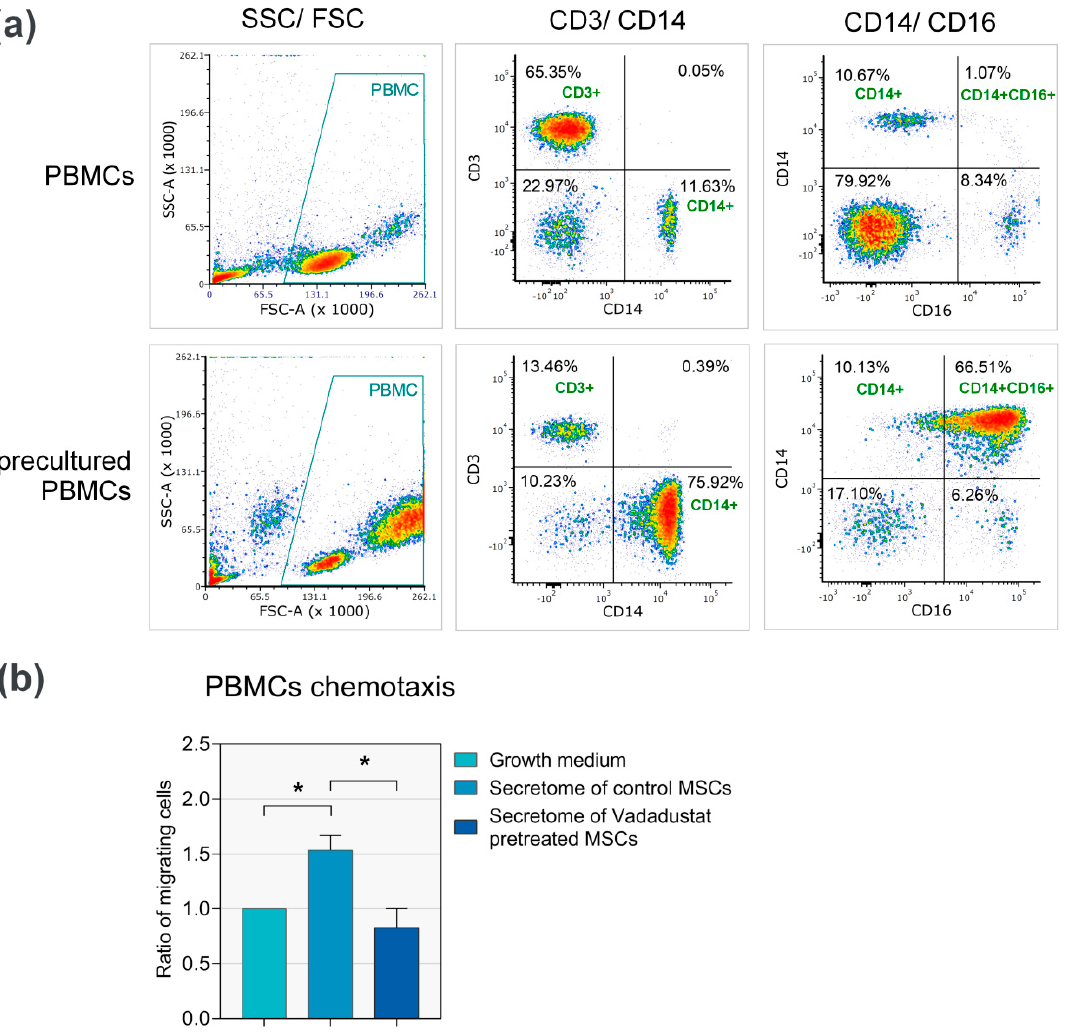
Figure 5. Assessment of the chemotactic properties of the secretome of Vadadustat preconditioned bone marrow-derived mesenchymal stromal cells (BM-MSCs). ( a ) Flow cytometric analysis of lymphocyte populations in peripheral blood mononuclear cells (PBMCs) isolated or precultured in plates based on CD3 (PerCP), CD14 (FITC) and CD16 (PE-Cy7) staining. PBMCs were gated based on FSC and SSC, percentages of monocytes (CD14 + ) and activated monocytes (CD14 + CD16 + ) in PBMCs are shown in quadrants. ( b ) The analysis of chemotactic properties of secretome from 6 BM-MSCs populations cultured for 24 h under standard conditions (control) and with Vadadustat on the migration of monocyte-enriched peripheral blood mononuclear cells (PBMCs) (precultured PBMCs). The rate of cell migration is presented as the ratio of migrating cells ± SEM (standard error of the mean), obtained by comparing the fluorescence of PBMCs migrated to the growth medium (denoted as 1) with the fluorescence of PBMCs migrated into the secretome of control and Vadadustat pretreated MSCs. * Indicates the statistically significant ( p < 0.05) differences obtain by Wilcoxon matched-pairs signed-rank test in the groups of related data with abnormal distribution, and by Student’s t-test in the groups of related data with confirmed normal distribution. Cell migration from the inserts to the basal compartment of plate wells was assessed after 48 h of monocyte-enriched PBMCs incubation. The results presented in Figure 5b show that within 48 h of incubation there was a significant, 53% increase in PBMCs/monocytes migration in wells containing secretome of control MSCs compared to wells with growth medium alone. Conversely, there was a statistically significant 46% decrease in cell migration in wells with secretome of Vadadustat-preconditioned MSCs compared to migration in wells with secretome of control MSCs.